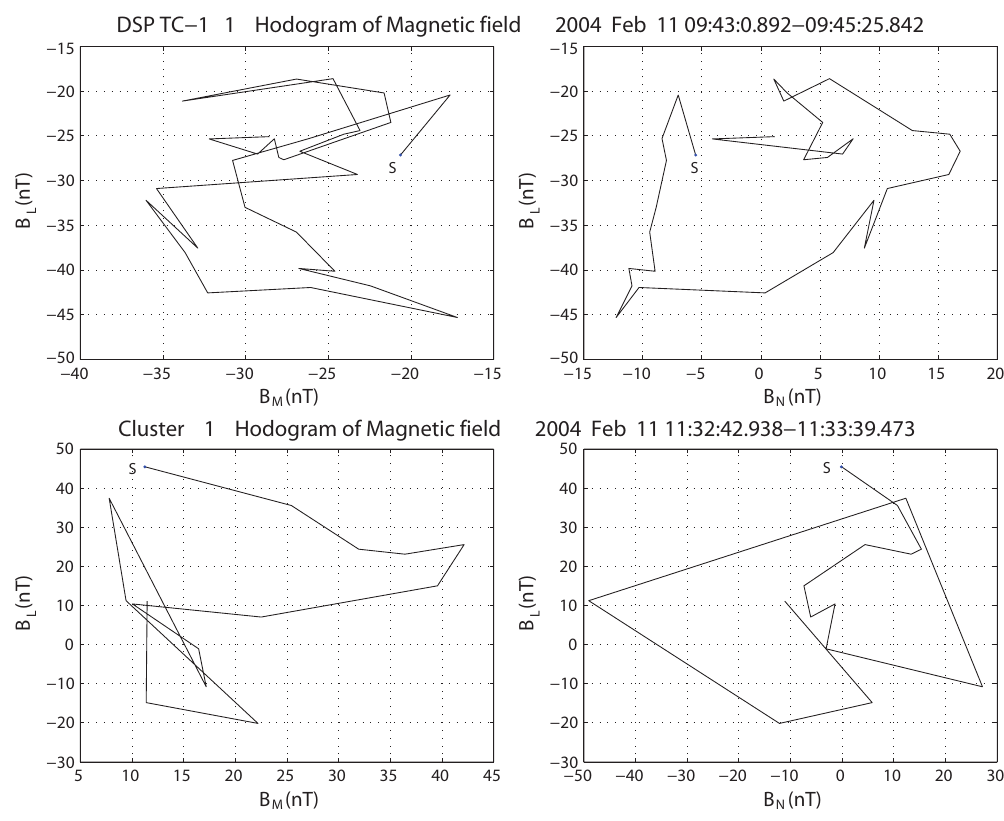
Fig. 4. Hodograms of the magnetic field in LMN coordinates for the periods 09:43:01–09:45:26UT observed by TC-1 spacecraft and for the periods 11:32:43–11:33:39UT measured by Cluster 1. Left and right panels show L-M and L-N representations. The black dot point (marked by “S”) presents the start point in each